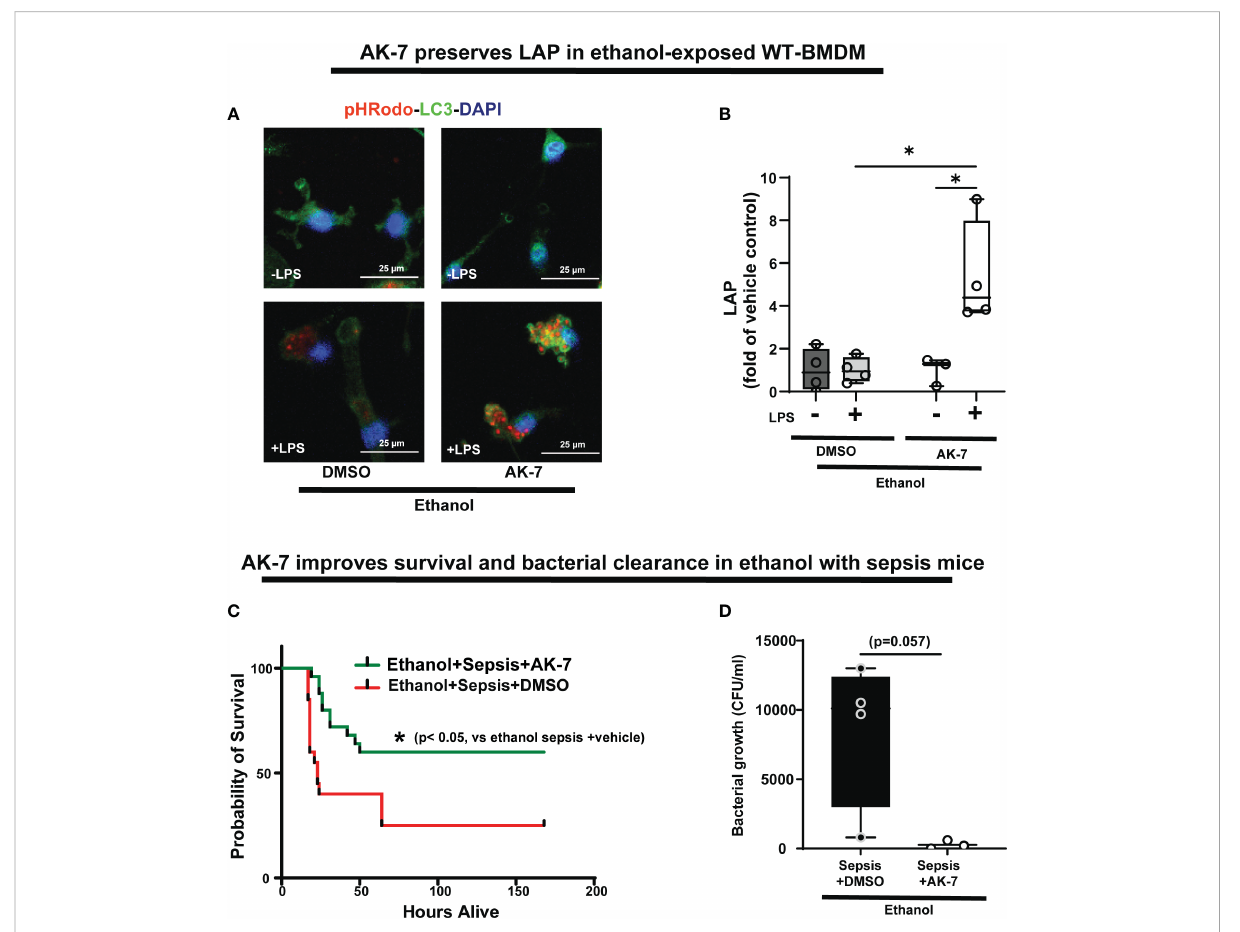
FIGURE 10 The effect of AK-7 survival in ethanol with sepsis mice and LC3-associated phagocytosis in Ethanol-exposed macrophages. (A) Representative images of Ethanol-exposed WT-BMDM with AK-7 or DMSO ± LPS. Staining of intracellular pHrodo bioparticles (red) and LC3 (green). (B) Fluorescence quanti fi cation of LAP in Ethanol-exposed WT-BMDM with AK-7 or DMSO ± LPS quanti fi ed as the co-localization of intracellular pHrodo (red) and LC3 (green) per cell (n=4; * p<0.05). (C) Effect of AK-7 vs. DMSO treatment on 7-day survival in ethanol-drinking WT mice with cecal slurry-induced sepsis. Kaplan-Meier survival curve shows signi fi cantly higher survival in AK-7 vs. DMSO treatment (AK-7: 60% vs. Vehicle: 25%) (n=10 each group; *p<0.05 vs ethanol sepsis + DMSO using Log-Rank test). (D) Peritoneal lavage from Ethanol-exposed and AK-7 or DMSO treated WT sepsis mice at 8-days post-CS injection. Bacterial colony forming units (CFU) are